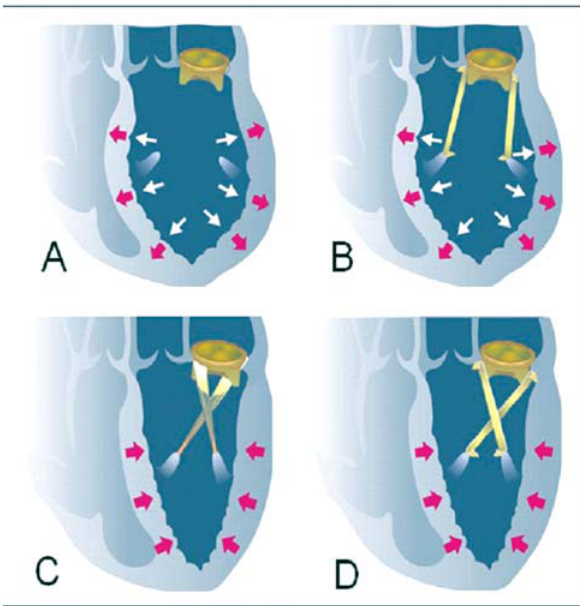
Fig. 1 - (A) Remodelamento patológico do VE pós retirada do ASV; (B) dinâmica funcional do ASV com enxerto de PB em paralelo; (C) papilopexia cruzada com ASV nativo; (D) papilopexia cruzada com fitas de